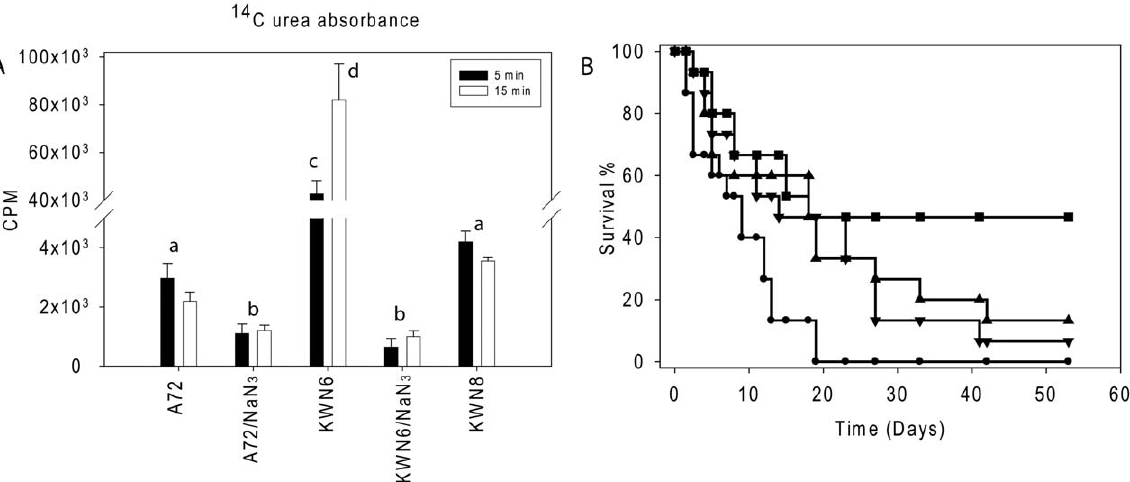
Figure 1. Dur1,2p function in urea metabolism and virulence. (A) . Urea uptake by WT (A72), dur1,2 D /dur1,2 D mutant and reconstituted C. albicans strain dur1,2 D ::DUR1,2/dur1,2 D ::DUR1,2. Radioactive uptake into 4 2 5 6 10 6 cells is presented after exposure to 14 C urea for 5 and 15 min in the absence or presence of sodium azide. Values shown are the average of triplicate experiments 6 SE. Closed bars indicate 5 min uptake, and open N bars indicate 15 min uptake of radioactive urea. (B) . Effect of DUR1,2 deletion on mouse mortality following intravenous infection. Survival of mice ), the null mutant KWN6 ( & ), single copy reconstituted KWN7 ( . ), fully reconstituted KWN8 ( m ), and an injected with WT C. albicans A72 ( uninfected control group of 5 mice (not shown) was assessed daily. Each infected group contained 15